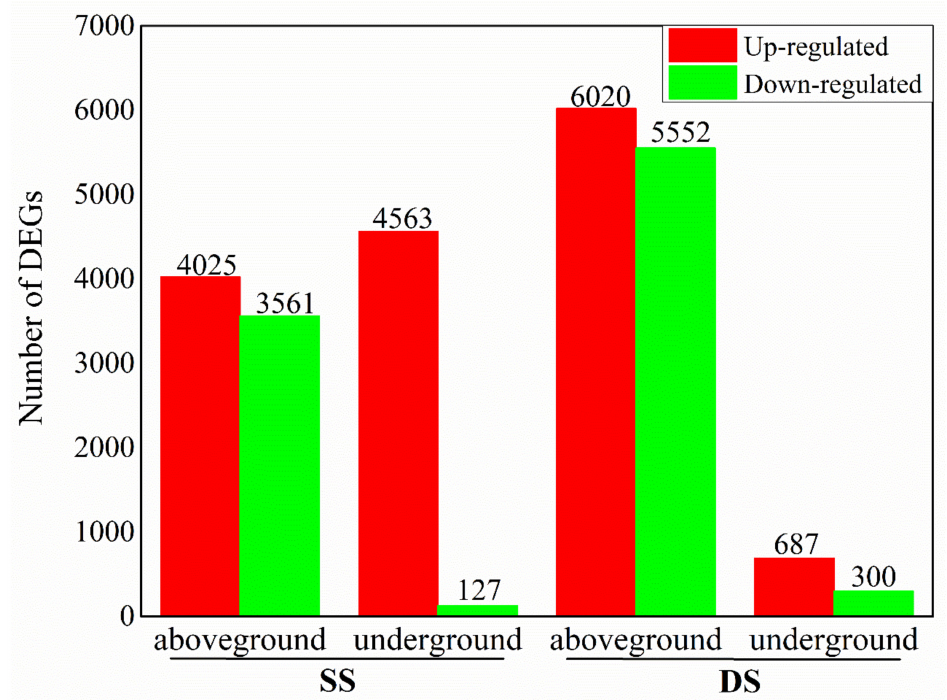
Figure 1. The number of differentially expressed genes (DEGs) in aboveground and underground tissues of bermudagrass under shallow submergence (SS) and deep submergence